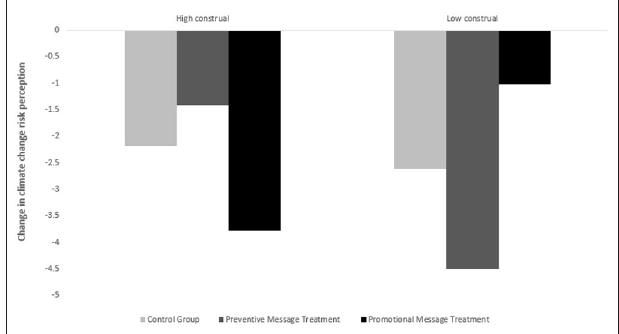
FIGURE 2 | Change in pro-environmental behavioral